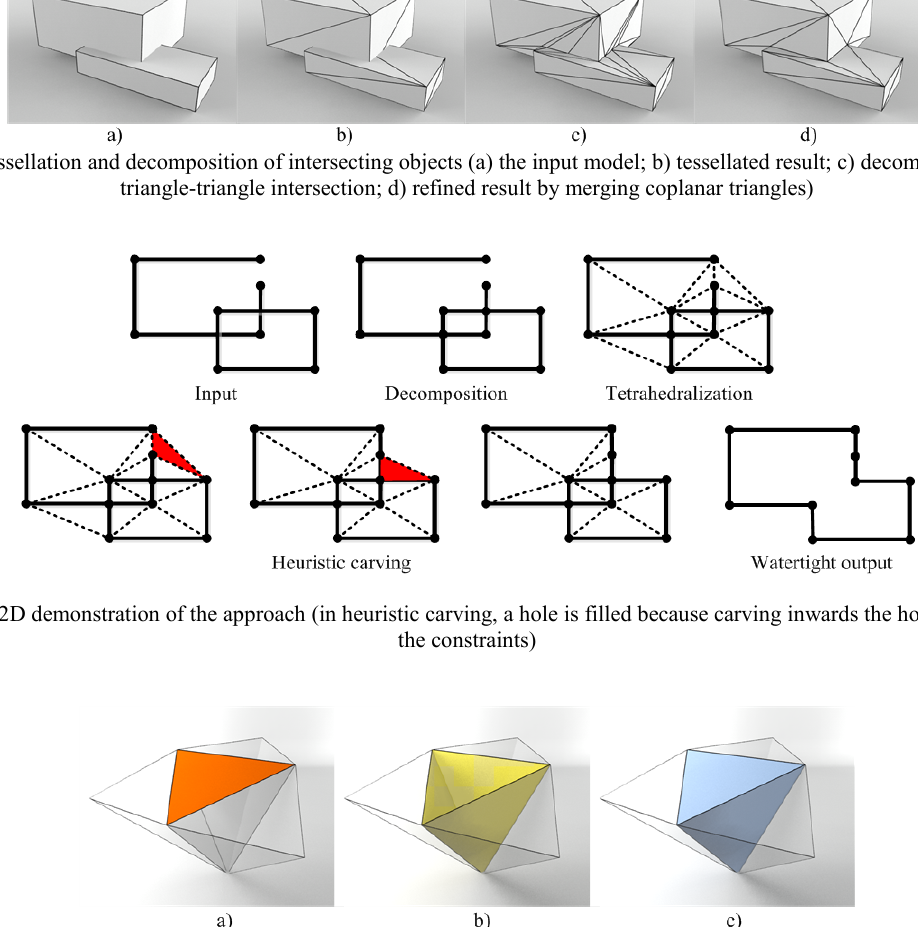
Figure 4. Demonstration of the carving operation (a) the candidate tetrahedron with a triangular facet colored in red 1 ; b) after carving, the rest three triangular facets are classified as candidate triangles colored in yellow; c) if the tetrahedron is preserved, all its triangular facets are classified as fixed, colored in blue) 1 This color configuration will be used throughout this paper (current candidate tetrahedron: red; candidate triangles: yellow; fixed triangles: